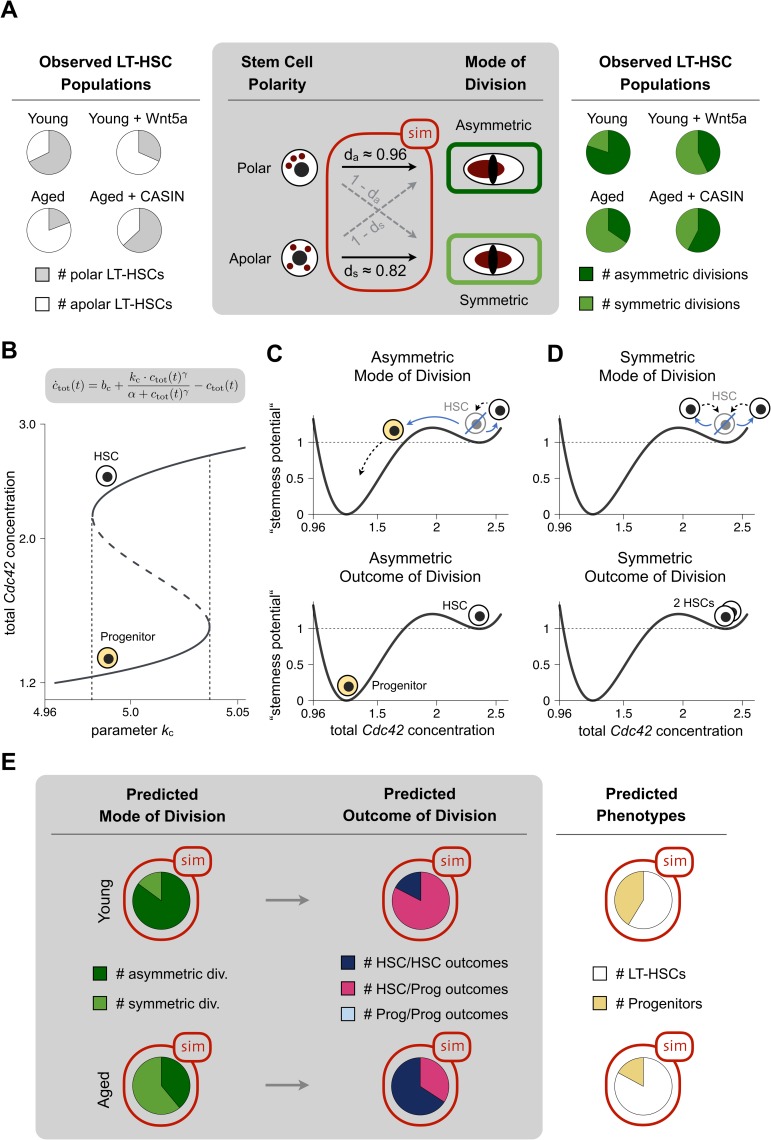
Polarity is a major driver of asymmetric cell division, and Cdc42 allocation predicts potential.(A) Pie charts in white/grey show the observed ratios of polar versus apolar HSCs in young, aged, Wnt5a-treated young, and CASIN-treated aged HSC samples, respectively [15, 16]. Pie charts in green show the observed modes of division for the respective cell populations (see Fig 2C–2E). The intermediate panel depicts the possible connections (arrows) between cell polarity status and mode of division. Application of a maximum likelihood approach on a simple transition model (with da being the probability for a polar HSC to undergo an asymmetric mode of division and ds being the probability for an apolar HSC to undergo a symmetric mode of division) allows estimating the most probable configuration for da and ds, thereby supporting the notion that the solid arrows represent the most prominent choices. (B) The bifurcation diagram illustrates the differentiation switch. For certain parameter values of kc, the ODE for total Cdc42 concentration ctot(t) allows for 2 stable steady states: (I) total Cdc42 is highly expressed (associated with the HSC state) and (II) total Cdc42 is lowly expressed (associated with the progenitor state). (C, D) The pseudo-potential (“stemness potential”) landscape for total Cdc42 concentration with two stable steady states (two “valleys,” representing HSCs and progenitors). For HSCs undergoing asymmetric cell division (blue line in panel C), one daughter receives lower Cdc42 concentration (“passes the hill”) and progresses into the progenitor state (dashed arrow), while the other daughter retains the stem cell state. Daughters of HSCs undergoing symmetric division (blue line in panel D) retain their configuration. (E) The panels summarise the mechanistic model results (red boxes) for populations of young and aged HSCs, respectively. The pie diagrams on the right-hand side show the predicted ratios of resulting cell types (HSCs versus progenitors) derived from a population of dividing young and aged HSCs, respectively. The primary data the figure is based on are provided in S1 Data. CASIN, Cdc42 activity specific inhibitor; Cdc42, cell division control protein 42; HSC, hematopoietic stem cell; ODE, ordinary differential equation.